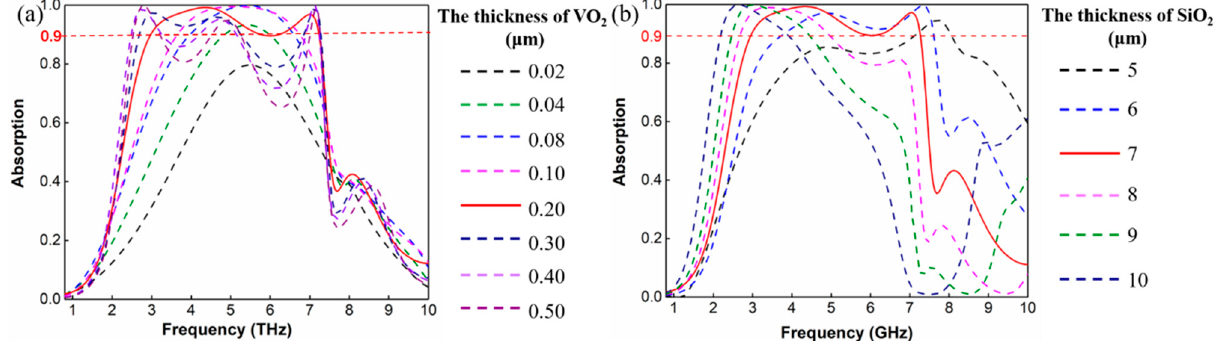
Figure 7. Absorption spectrum of different thicknesses of ( a ) VO 2 and ( b ) SiO 2 when σ equals 2 × 10 5 S/m.